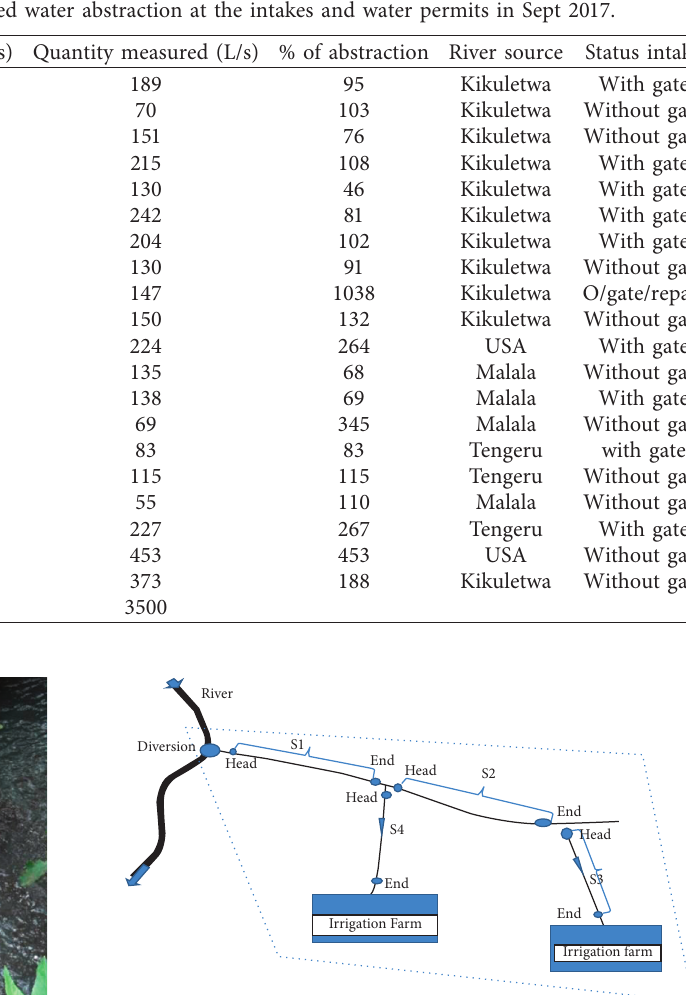
Figure 4: Typical layout of traditional irrigation scheme infra- structure (s �